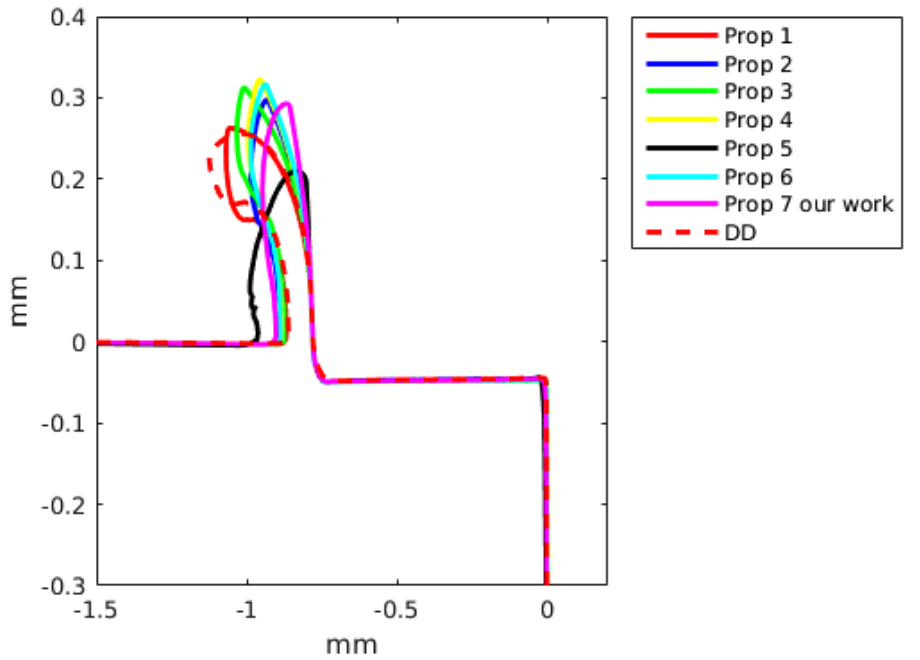
Figure 11. Predicted chip shape using two constitutive models: dislocation density (DD) and